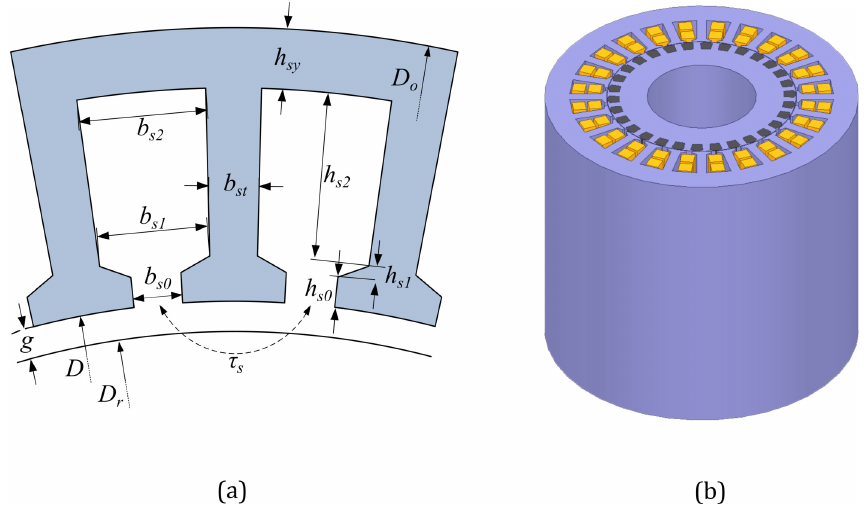
Figure 2. ( a ) Representation of the used stator topology and ( b ) 3D view of the SPIM topology under